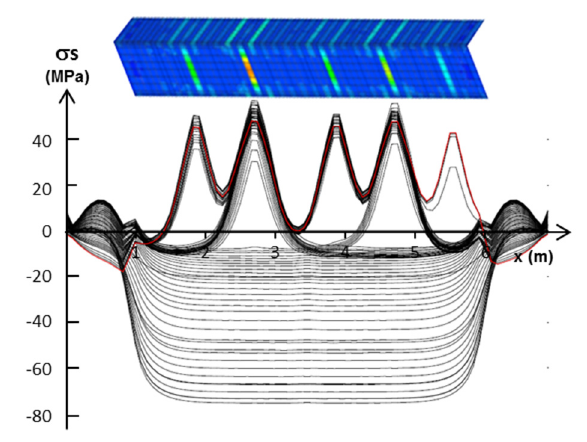
Figure 15. Stress profiles along the tie length (VS 2%) in the reinforcement over time (red curve obtained at the occurrence of the 5th crack, 140 h after casting).